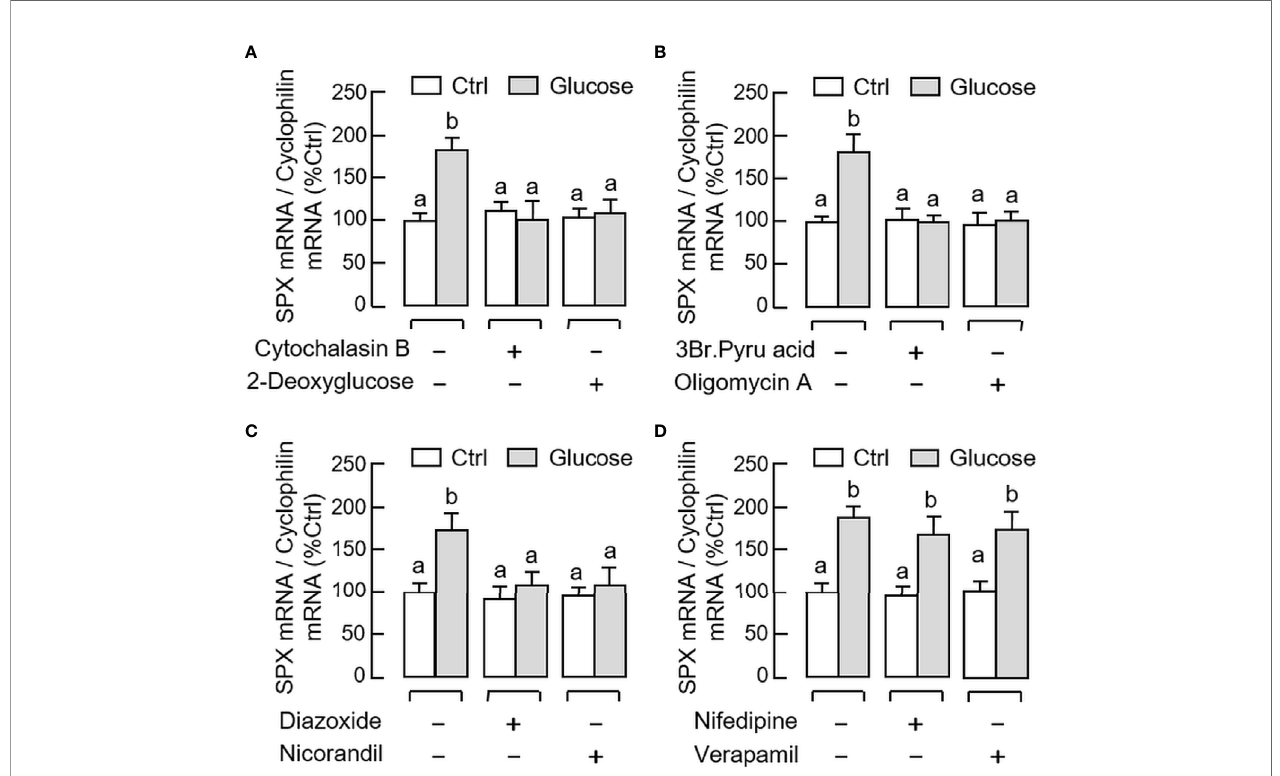
FIGURE 7 | Signal transduction mediating glucose-induced SPX gene expression in mouse gastric mucosal cells. Gastric mucosal cells were challenged with glucose (12 mg/ml) for 6 h in the presence or absence of (A) the GLUT blocker cytochalasin B (10 µM) or “ non-metabolizable ” glucose analog 2-deoxyglucose (1 mM), (B) the hexokinase inhibitor 3Br.Pyru acid (10 µM) or ATP synthase inactivator oligomycin A (5 µM), (C) the K ATP channel activators diazoxide (30 µM) or nicorandil (30 µM), and (D) the L-type voltage-sensitive Ca 2+ channel inhibitors nifedipine (10 µM) or verapamil (10 µM), respectively. Data presented (mean ± SEM, N = 8) were analyzed by one-way ANOVA followed by Newman-Keuls test and the groups denoted by different letters represent a signi fi cant difference at p <